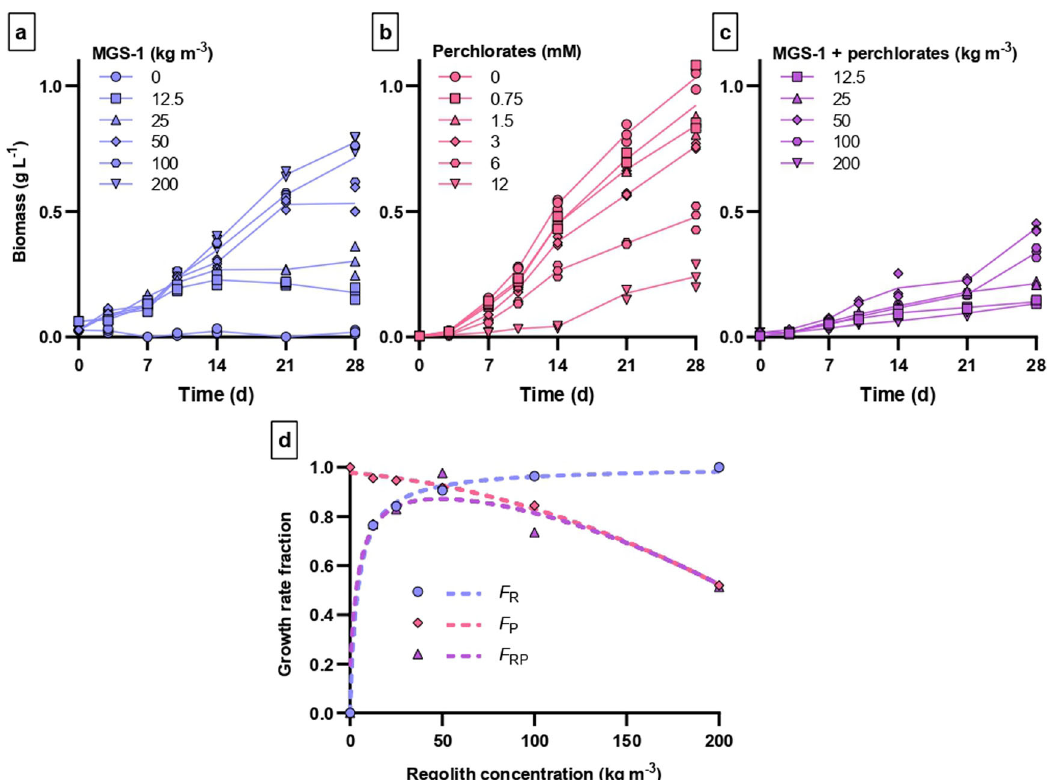
Fig. 2 Growth of Anabaena sp. PCC 7938 with regolith and perchlorates. a Growth curves in bi-distilled and de-ionized water (ddH 2 O) supplemented with various concentrations of a perchlorate-free simulant of Martian regolith (MGS-1). b Growth in BG11 0 spiked with various concentrations of perchlorate ions. c Growth in ddH 2 O supplemented with various concentrations of MGS-1, and spiked with perchlorate ions at concentrations corresponding to 0.6 wt% of the indicated regolith concentrations. d Normalized growth rate as a function of regolith concentration ( F R ), perchlorate concentration ( F P ), or concentration of perchlorate-containing regolith ( F RP ). Symbols correspond to experimental data. Lines represent equations fi tted to the corresponding experimental results ( F P , F R ) or the product of these equations ( F RP = F P × F R